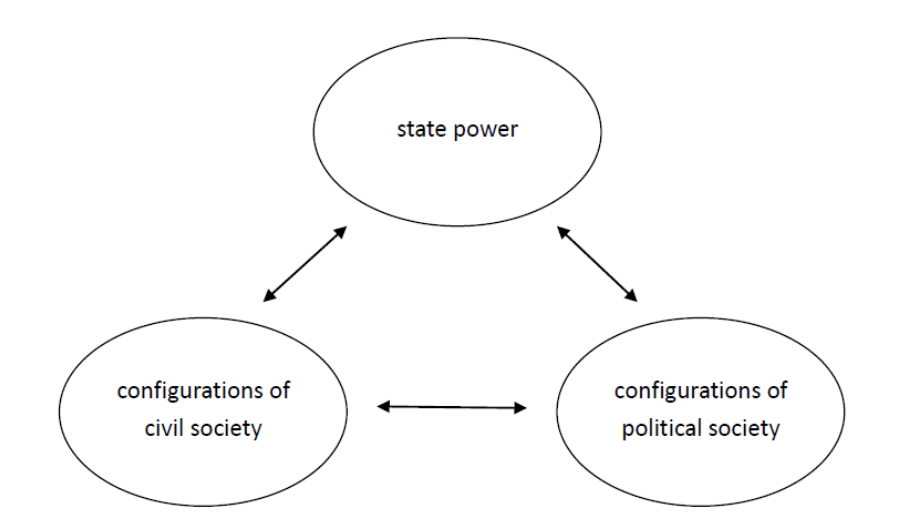
Figure 1 The state – civil society – political society analytical framework A Policy Device without Active Support from Civil